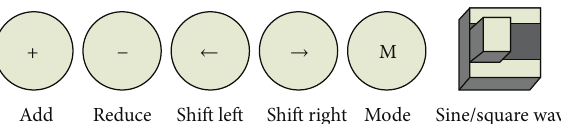
Figure 4: The interface circuit of LCD.